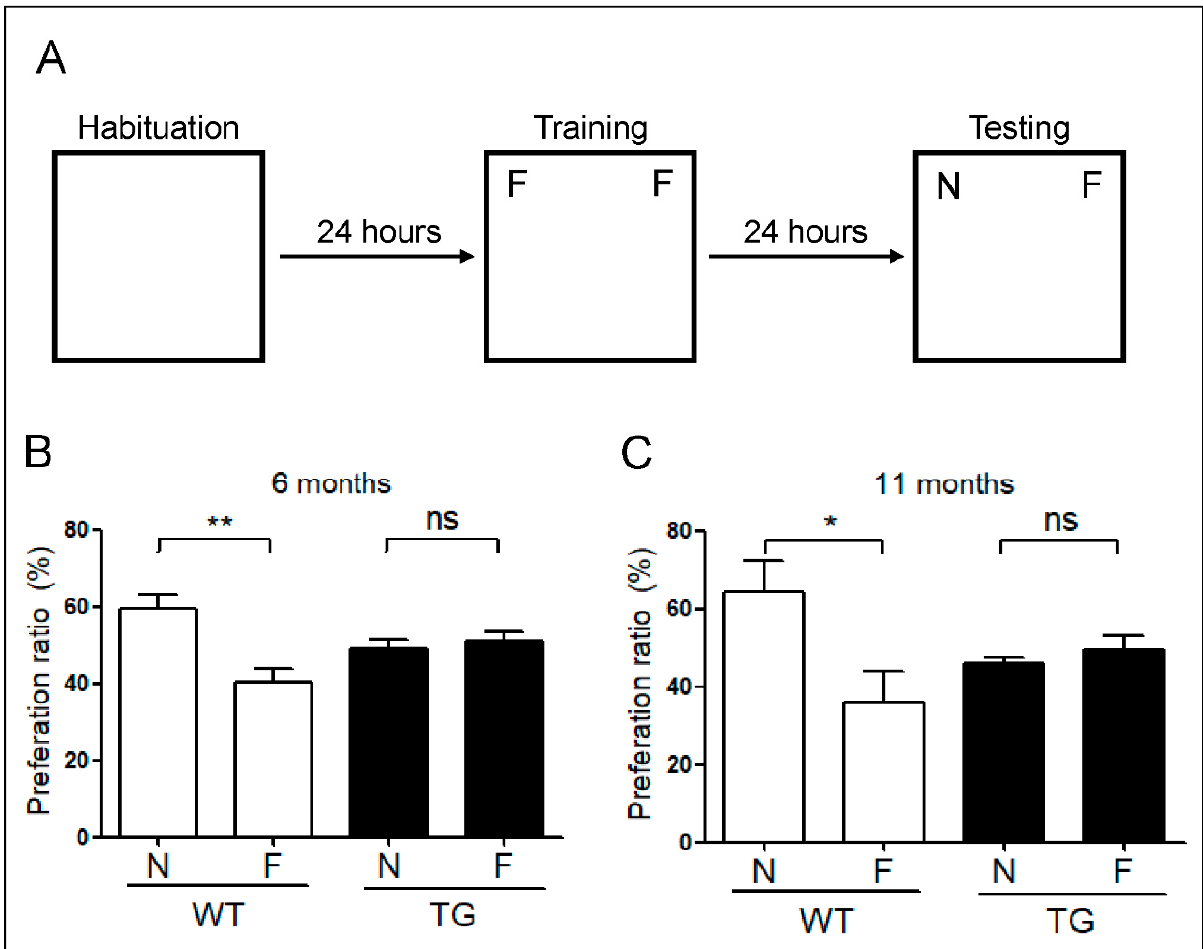
Figure 6. Object recognition test in 5xFAD mice. ( A ) Habituation training was performed for 3 days by exposing the animals to the experimental environment for 10 min a day in the absence of an object. A training session was conducted 24 h after the last habituation training. Mice were placed in the experimental setup in the presence of two identical objects and allowed to explore them for 10 min. After 24 h, the mice were returned to the experimental cage and observed while exploring the objects for 10 min. Two objects in the cage were familiar, and the third was a novel one. ( B ) Preference index of novel object recognition. In 6-month-old mice, the preference index levels were significantly different among WT, but not 5xFAD (TG) mice. ( C ) Preference index in the novel object recognition test. In 11-month-old mice, preference index levels were again significantly different among WT mice, whereas these levels did not differ among 5xFAD mice. Data are displayed as the mean ± SEM. *, p < 0.05; **, p < 0.01 relative to the indicated group using unpaired t -test ( n = 6–10). F, familiar; N, novel; TG, transgenic; WT, wild-type; SEM, standard error of mean; ns, no significance.